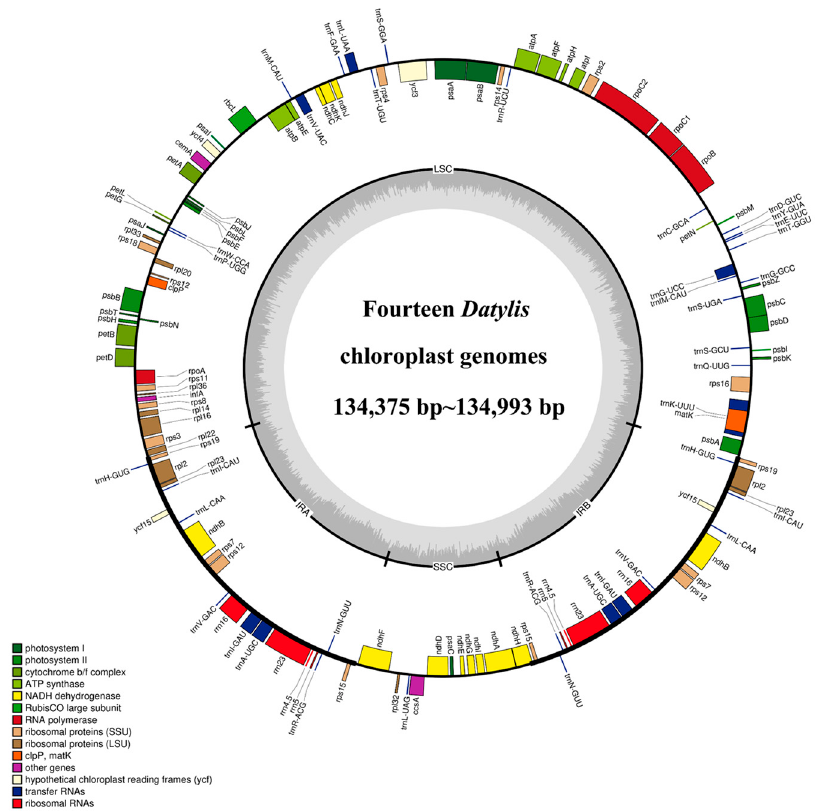
Figure 1. Representative cp genome of Dactylis subspecies. Genes drawn inside and outside of the circle are transcribed in clockwise and counter–clockwise directions, respectively. The colored bar indicates chloroplast gene groups. The dark gray bar graphs inner circle shows the GC content, and the light gray bar graphs show the AT content.